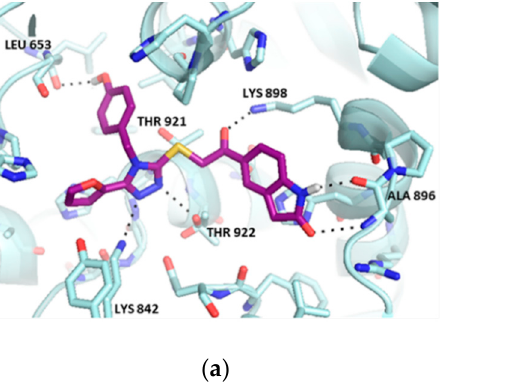
Figure 3. Predicted binding mode of ligands docked within the active site of OGT (PDB entry: 4GYY). ( a ) representation of compound 6 (purple); ( b ) representation of compound 9 (red). The ligand and the neighboring protein side-chains are shown as stick models, colored according to the chemical atom type (blue, N; red, O; yellow, S; orange, P). Hydrogen bonds are indicated by black dotted lines.